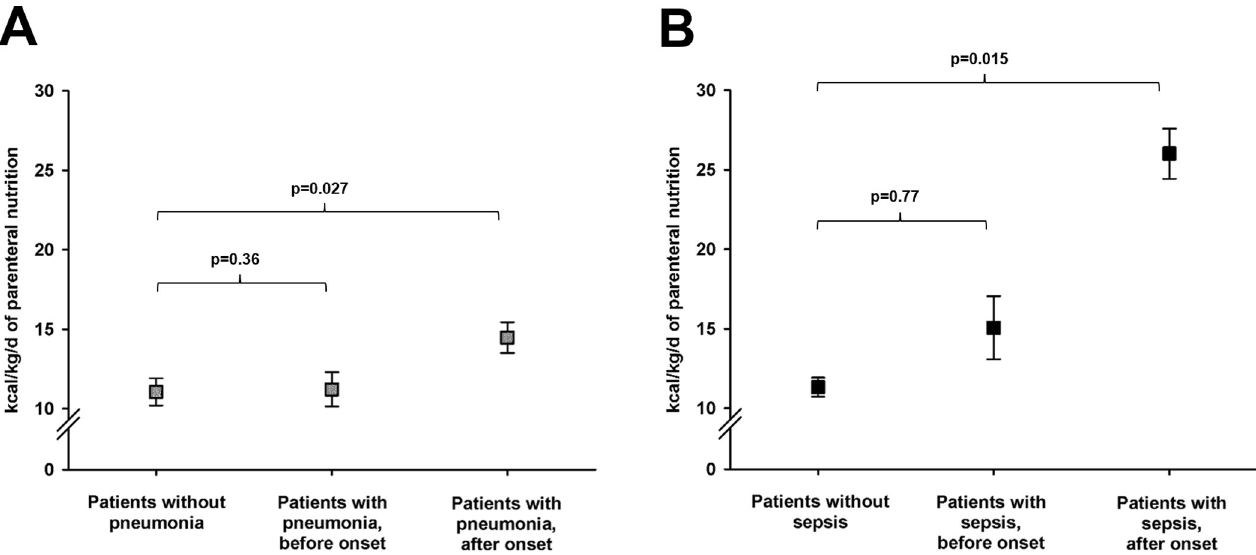
Fig 2. Amount of parenteral nutrition before and after the onset of severe infectious complications. Mean amount of supplemental parenteral nutrition (PN) in (A) patients without pneumonia (left first on the x-axis) and, in patients with pneumonia, before (second on the x-axis) and after (third on the x-axis) pneumonia onset; before the onset of pneumonia, there was no difference in PN compared to patients without pneumonia (OR = 1.01, 95% CI = 0.93–1.10), whereas after pneumonia onset, patients received more PN (OR = 1.19, 95% CI = 1.08–1.32); (B) mean amount of PN in patients without sepsis (left first on the x-axis) and, in patients with sepsis, before (second on the x-axis) and after (third on the x-axis) sepsis onset; before sepsis-onset, there was no difference in PN compared to patients without sepsis (OR = 1.98, 95% CI = 0.74–3.84), whereas after sepsis onset, patients received more PN (OR = 3.74, 95% CI =